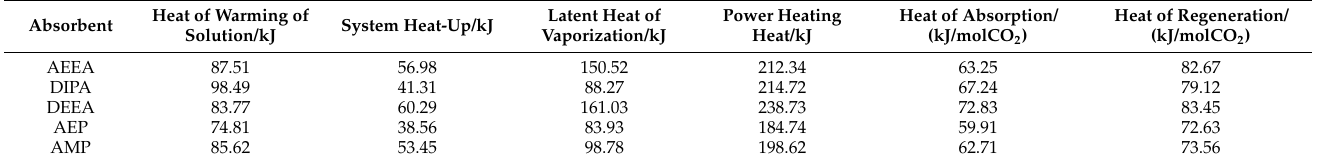
Table 3. Reaction heat test of 1mol/L base solution.